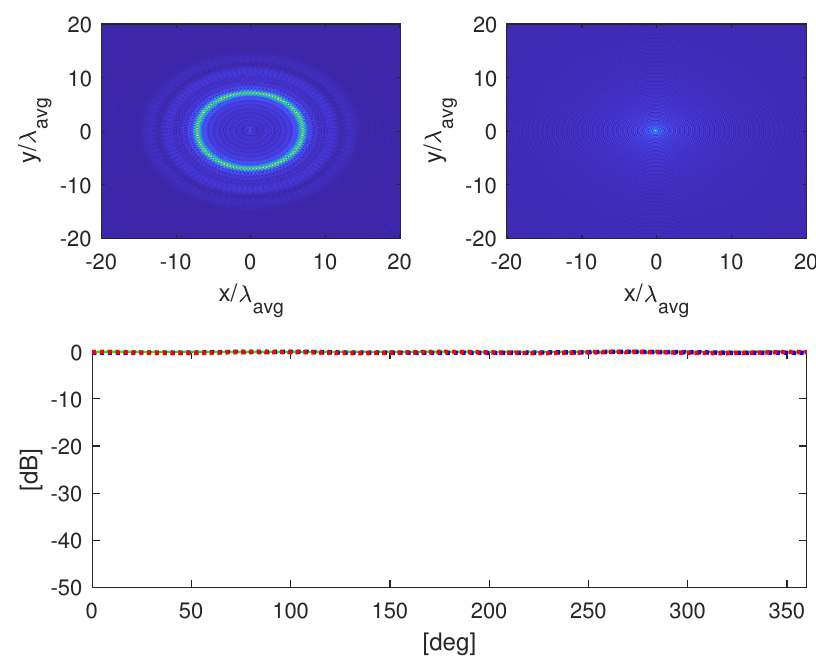
Figure 7. Object in Figure 5b. ( a ) Multi-frequency image. ( b ) Single-frequency image. ( c ) Normalized RCS at f = 4.5 GHz. The green line refers to the actual RCS, while the blue and red lines to the ones computed from the multi-frequency and single-frequency images, respectively.